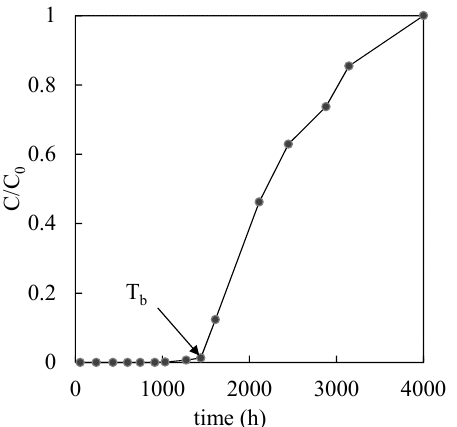
Figure 2. Example of a breakthrough curve for a generic thickness (L) of the reactive medium.